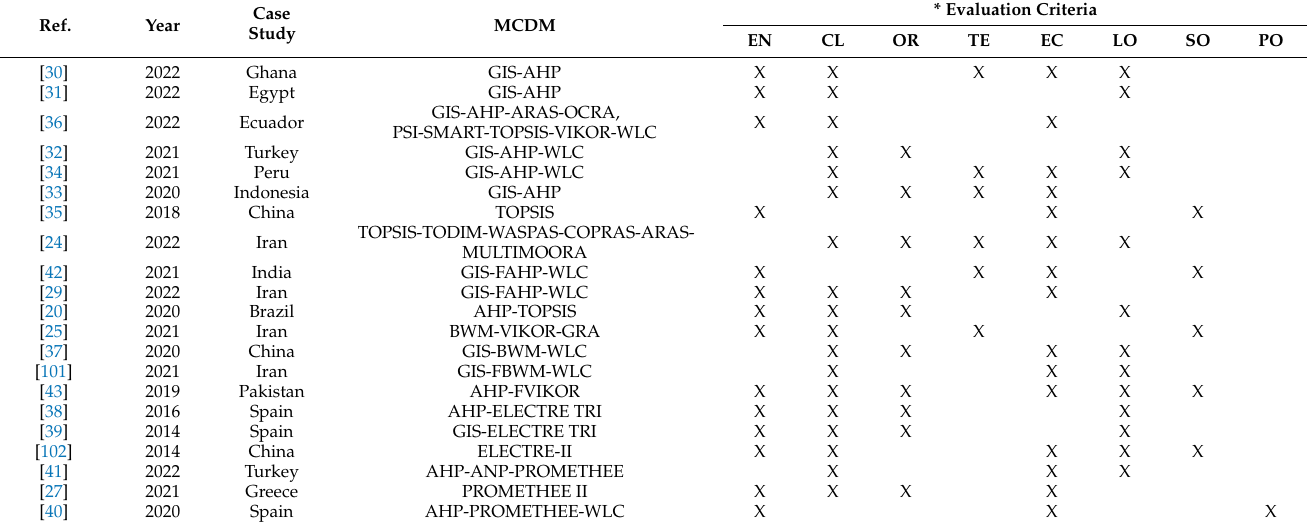
Table A1. Recent works conducted on applications of MCDM methods in PV power plant site selection.